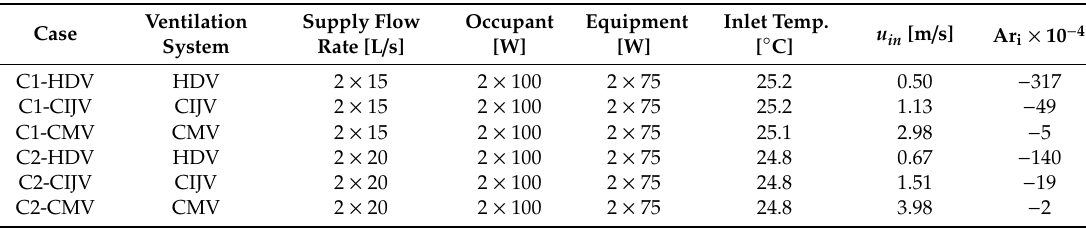
Table 1. Case conditions for different ventilation systems.